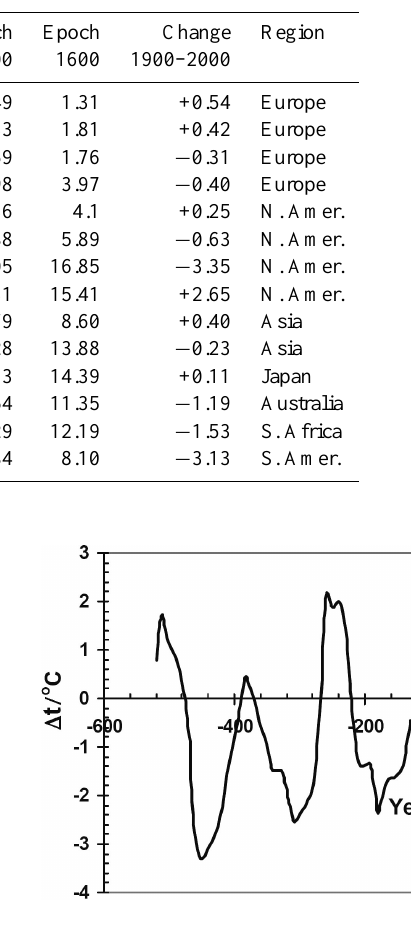
Fig. 9. Changes of planetary air temperature, 1t , near the Earth’s surface for the last 520 million years according to the pale- environmental records. According to Veizer et al.